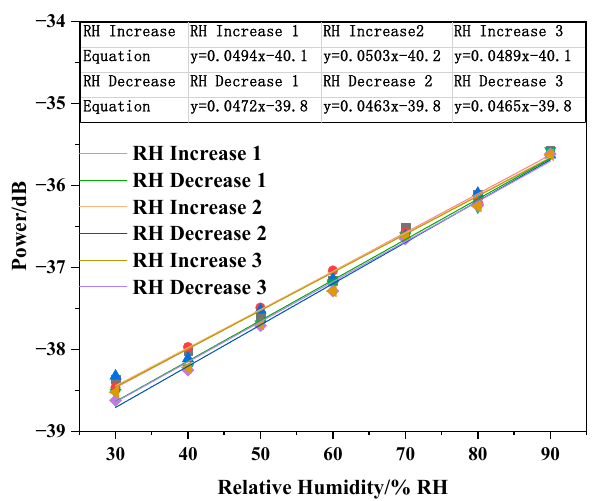
Figure 14. Sensor humidity response repeatability test fitting curve.